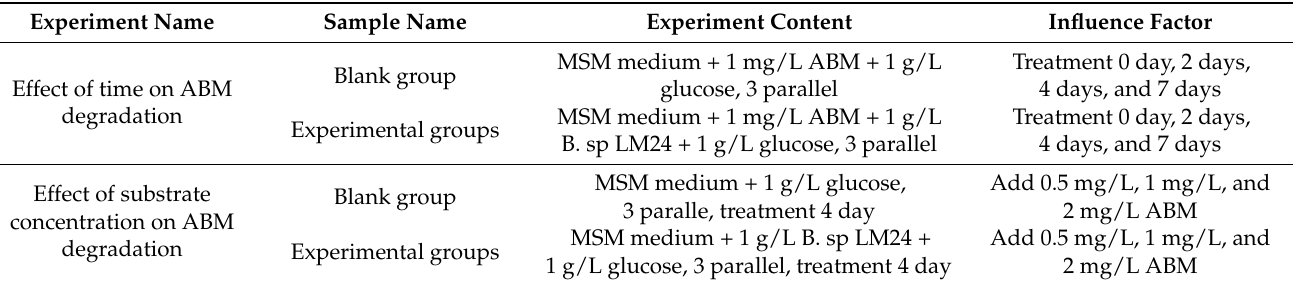
Table 1. Summary table of experimental